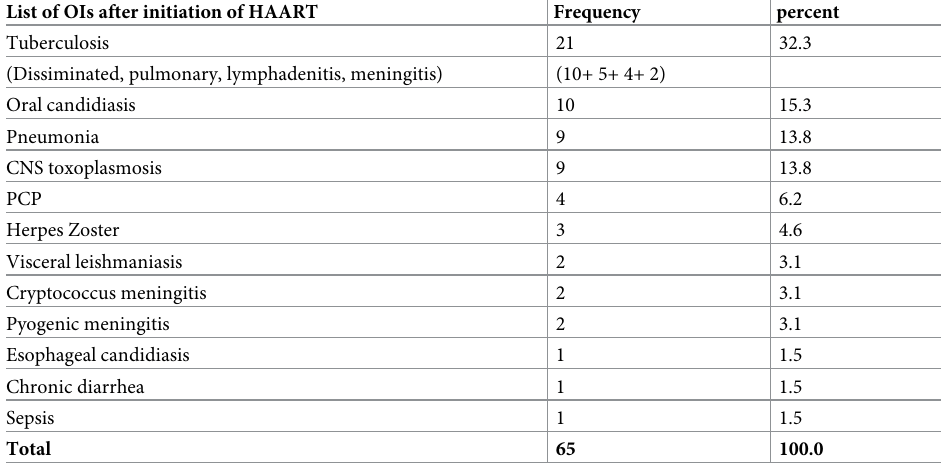
Table 3. List of HIV related OIs diagnosed after two weeks of HAART initiation at Ayder Referral Hospital, Mekelle, Ethiopia. (n = 317) January 2009 to May 2012. List of OIs after initiation of